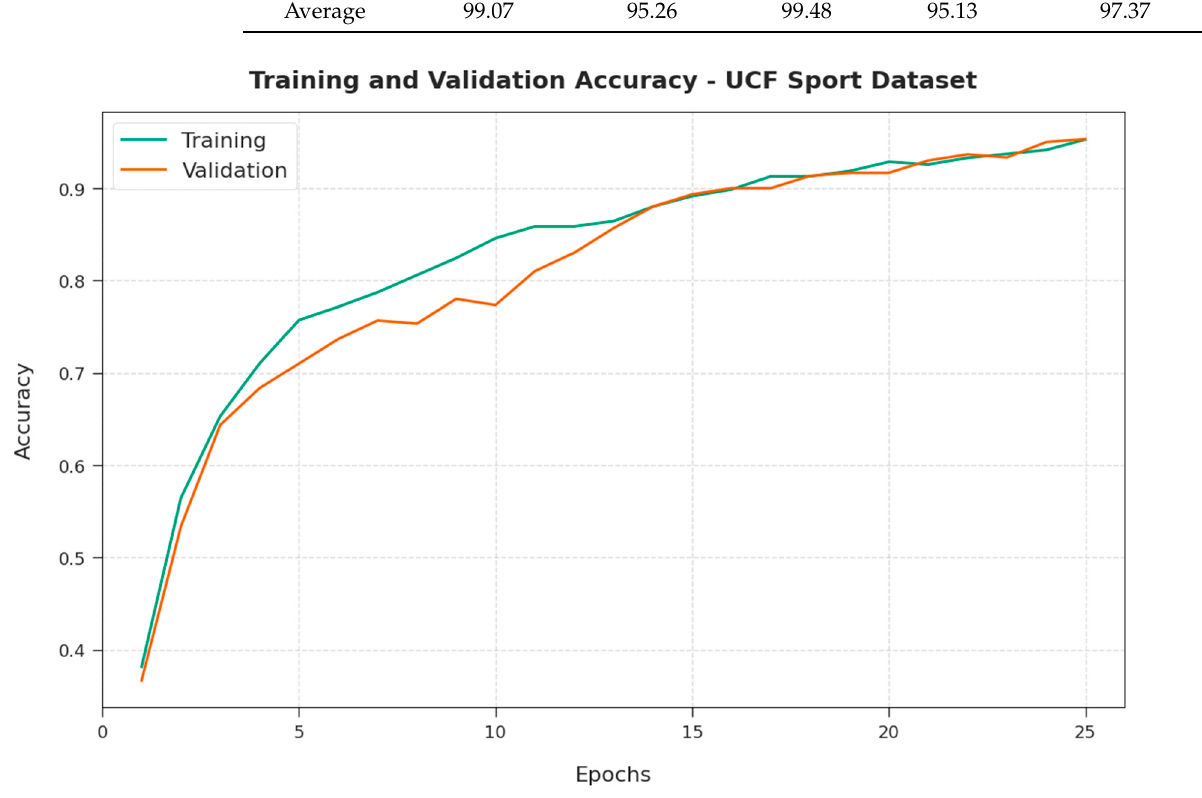
Figure 7. Training and validation accuracies of QWSA-HDLAR model on UCF Sport dataset.